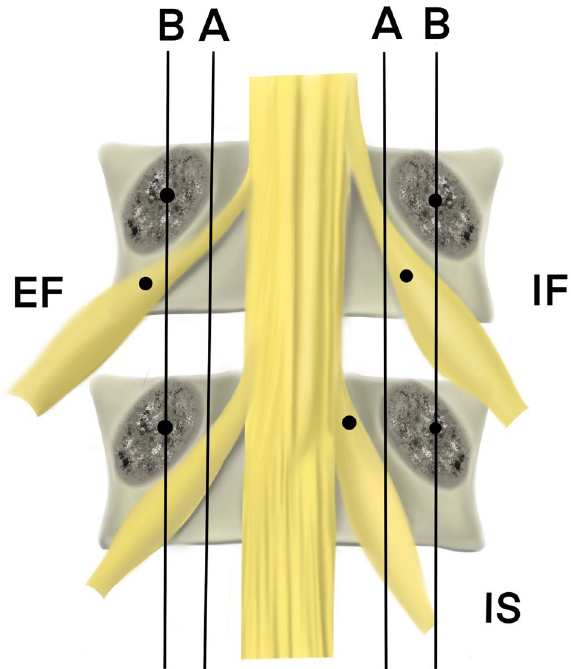
Figure 1. DRG locations. IS intraspinal, IF intraforaminal, EF extraforaminal. A is the line connecting the medial borders of pedicles of vertebral arch. B is the line connecting the centers of pedicles. If the proximal end of DRG lies proximal to A, it is intraspinal location; between A and B, intraforaminal; and distal to B, extraforaminal.